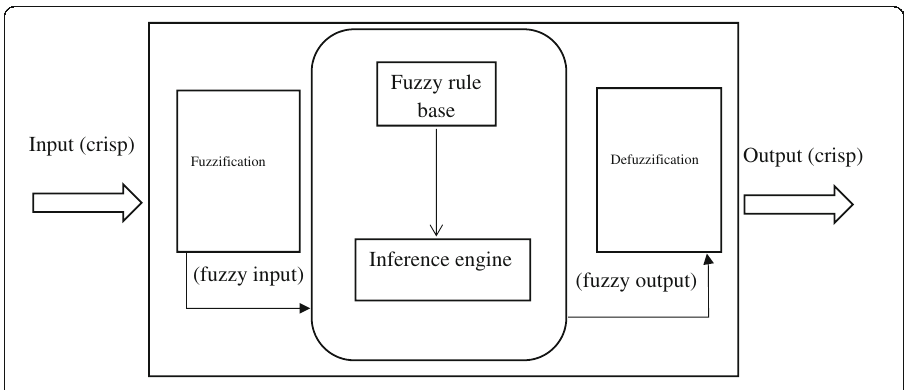
Fig. 10 Fuzzy inference system. The Fuzzy Inference System (FIS) provides a systematic process for